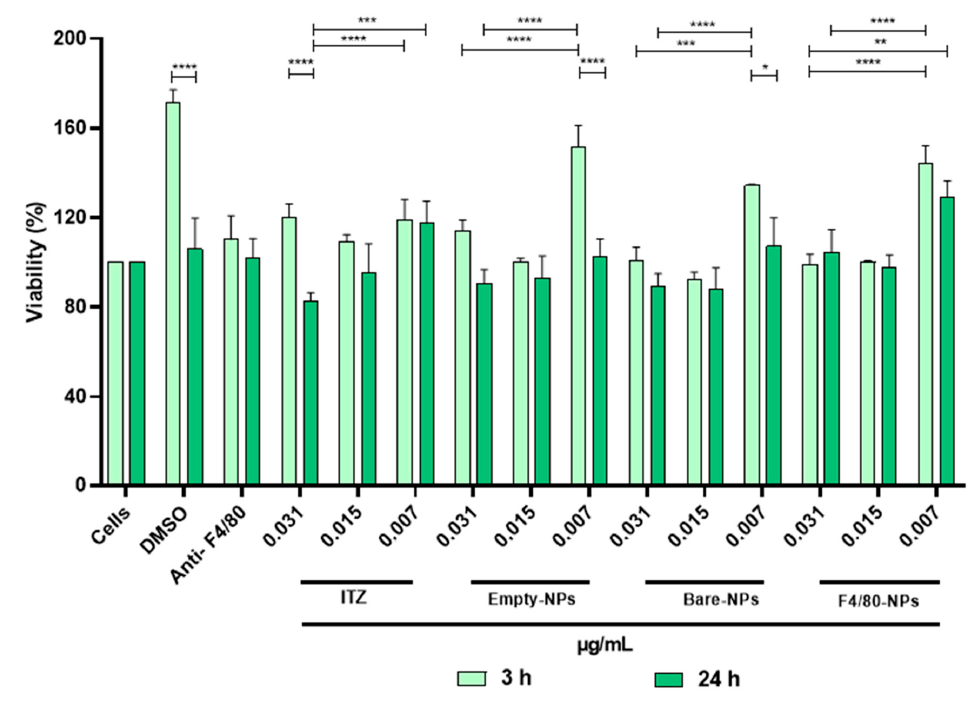
Figure 3. Cytotoxicity evaluation of ITZ encapsulated into functionalized PLGA75:25 TPGS-pH5 NPs with anti-F4/80 antibody on J774A.1 (peritoneal mice macrophages), with 0.031, 0.015, and 0.007 µg/mL of ITZ for 3 and 24 h, respectively by MTT and treatment with free ITZ and empty NPs or DMSO as controls. *, **, *** and **** indicate statistically significant differences with p < 0.01, p < 0.001, p < 0.0001, and p < 0.0001, respectively.